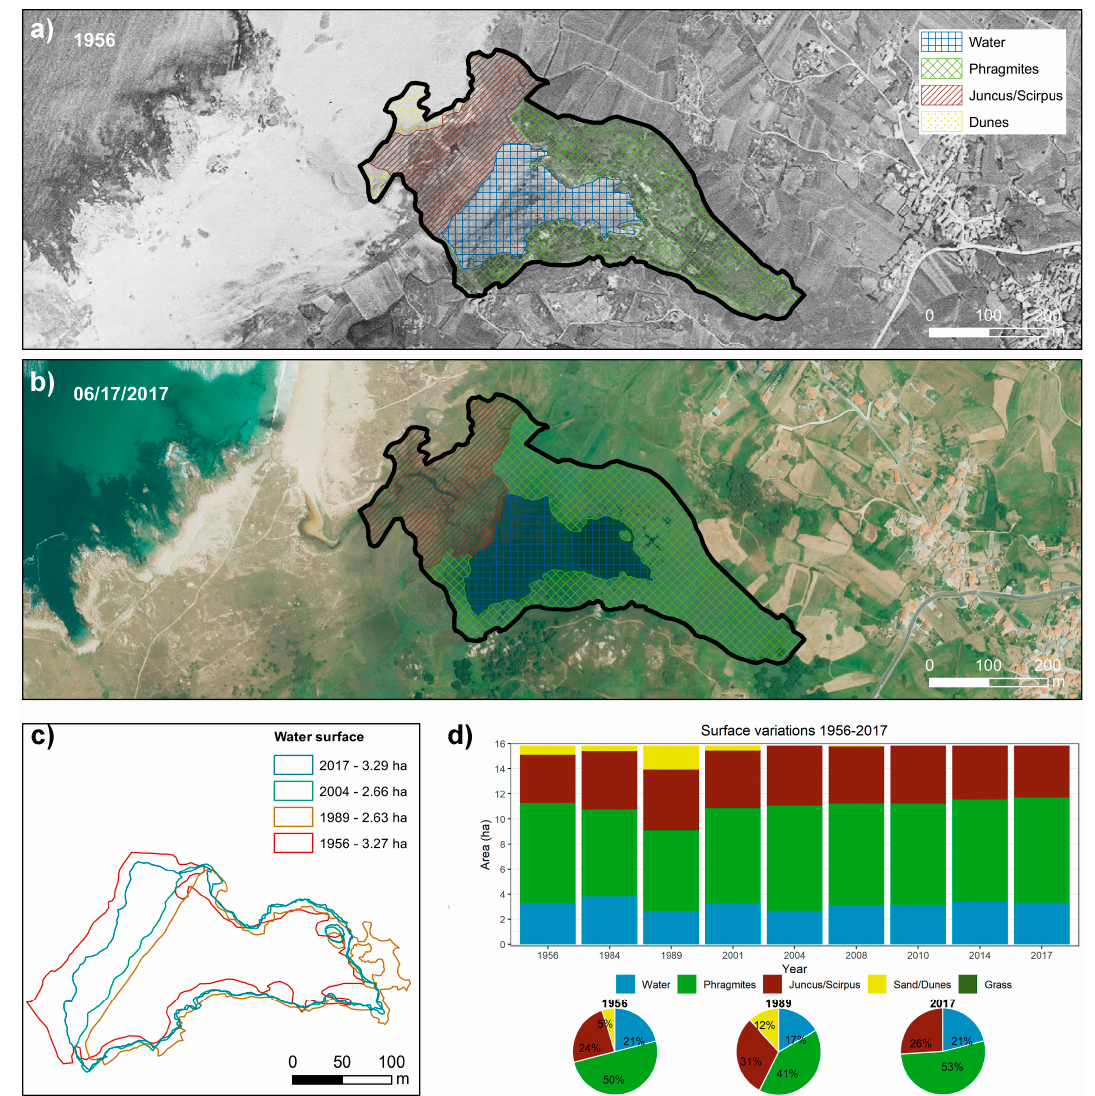
Figure 4. Cartography and data of the Vixán lagoon. ( a ) and ( b ) represent the areas covered by each category in 1956 and 2017, based on the aerial images taken each year (IGN). ( c ) shows variations in the water-covered area in 1956, 1989, 2004 and 2017 ( d ) shows variations in the free water body throughout the study period, and ( e ) shows the area (in ha) covered by each category in the different dates, as well as the percentage they represented relative to the total area of the lagoon.